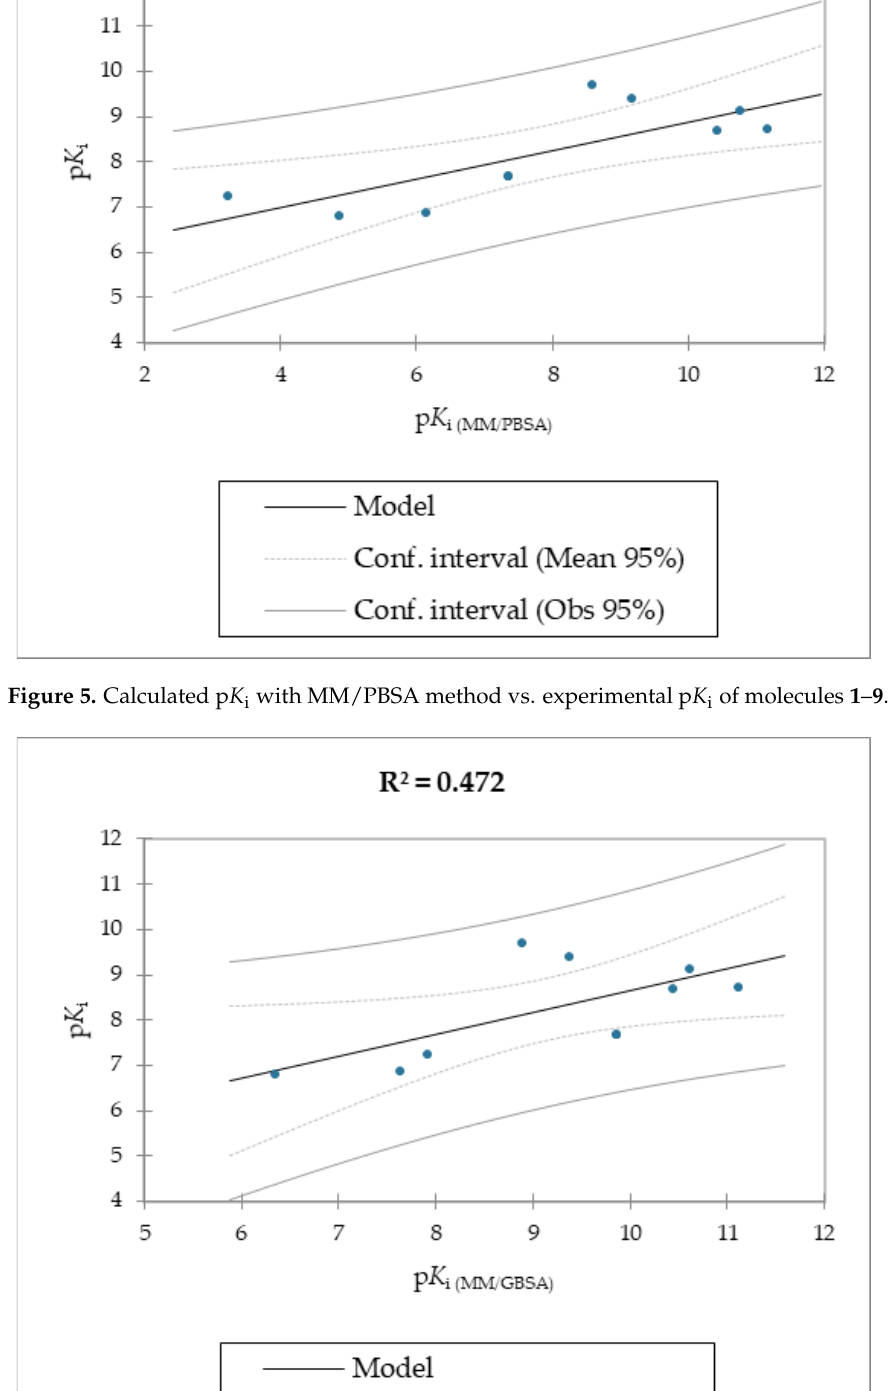
Molecules 2023 , 28 , x FOR PEER REVIEW